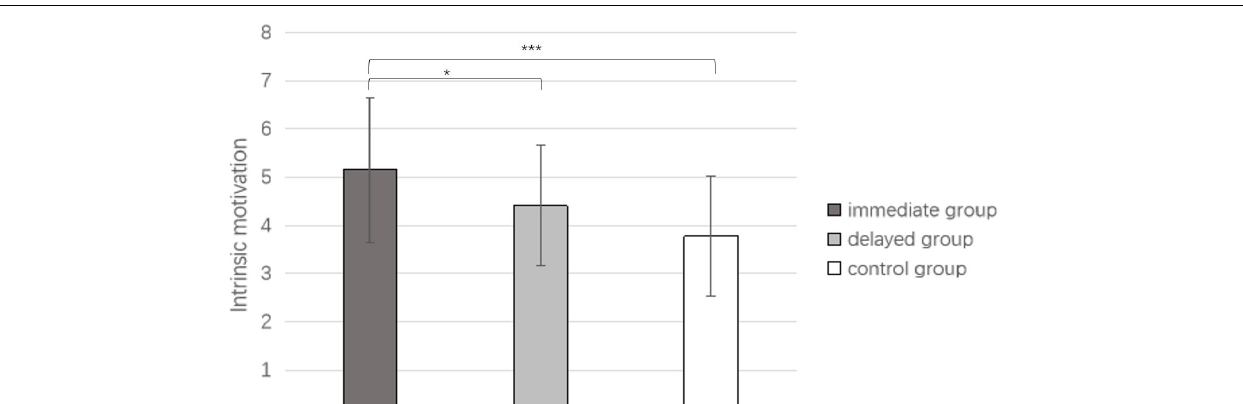
FIGURE 1 | Experimental procedure of Study 1a.